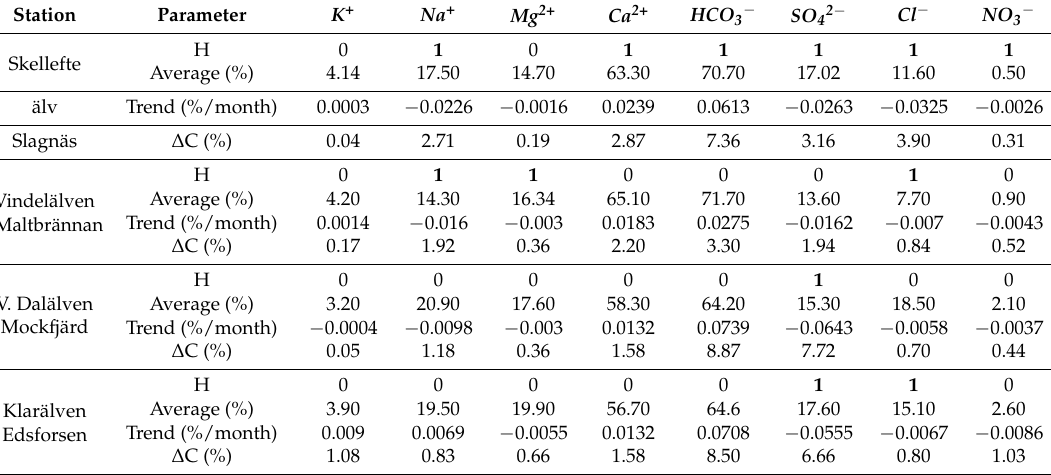
Table 6. The results of the Mann–Kendall trend test (H), average, trend and changing of relative concentration ( ∆ C) over 10 years (2000–2010) at the four Swedish stations analyzed in the present